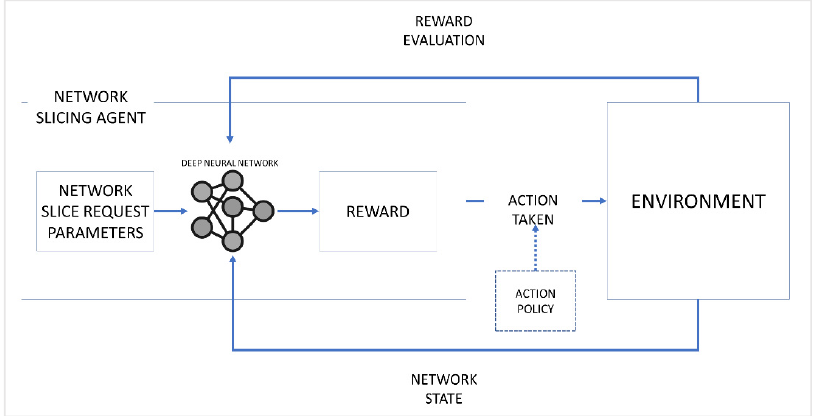
Figure 2. Deep Reinforcement Learning Model for the proposed work.